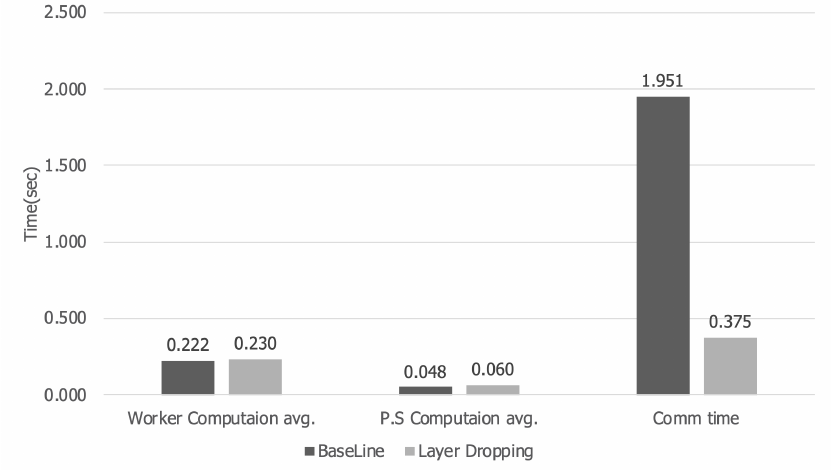
Figure 14. Communication time and computation time in a high bandwidth network.